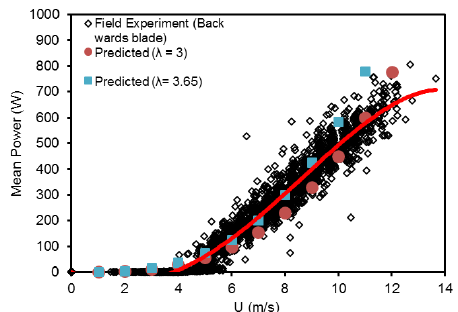
Figure 10. Results of power measurement of the rotor with a diameter of 2.4 m in the field [54] and predicted power values by data correlation from small-scaled rotors.